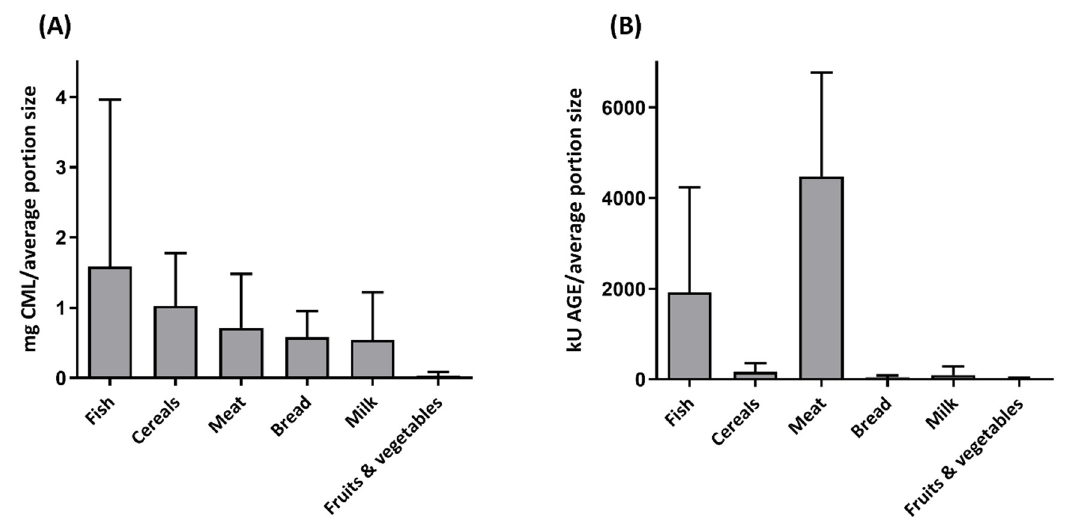
Figure 2. In the AGE content of food products using different quantification methods. ( A ) Data from Hull et al. based on mass spectrometry analyses [145]. ( B ) Data from analyses using N ε -carboxymethyl-lysine (CML) antibodies from Goldberg et al. based on ELISA analyses [141].